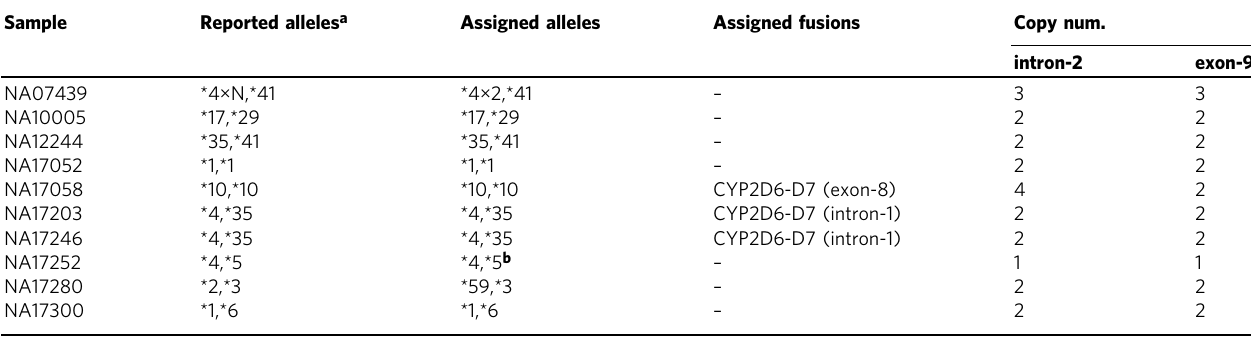
Table 2 Assigned CYP2D6 alleles of control